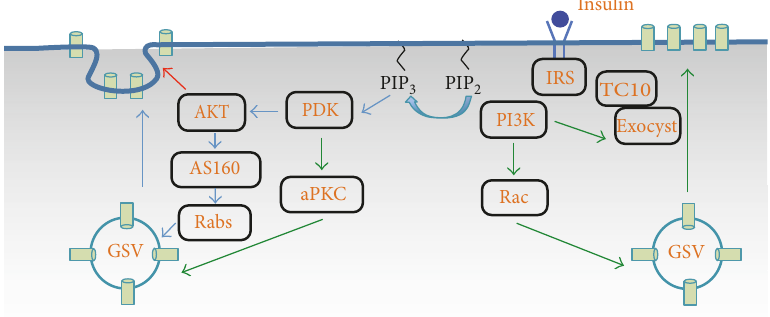
Figure 1: Schematic representation of insulin signaling pathways leading to GLUT4 vesicle exocytosis in muscle and adipose cells. See text for